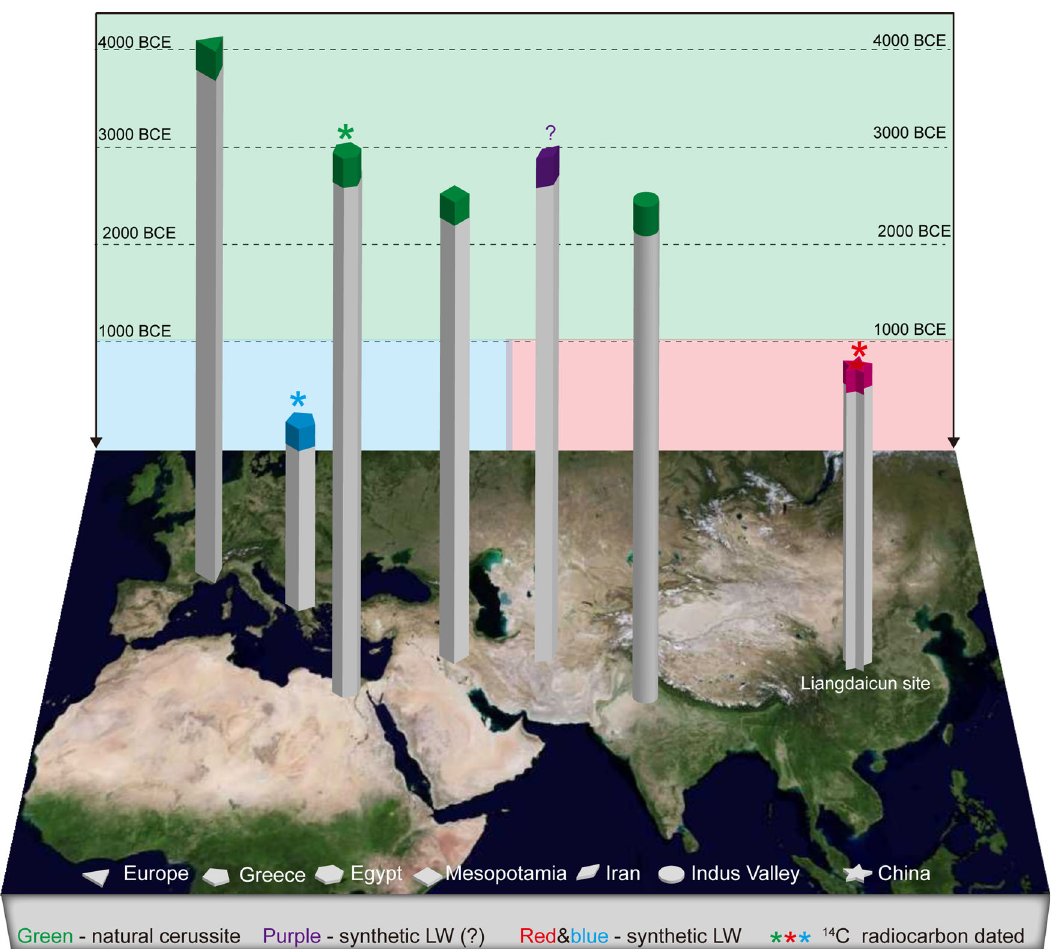
Fig. 1 The earliest use of lead white (LW) in different regions. The symbol shapes represent different regions, and their colors represent different natures of cerussite. This worldwide scenario of lead white use before the Common Era was drawn according to the references (Vidale et al., 2012; Hauptmann et al., 2016; Vidale et al., 2016; Beck et al., 2018; Kramberger et al.,